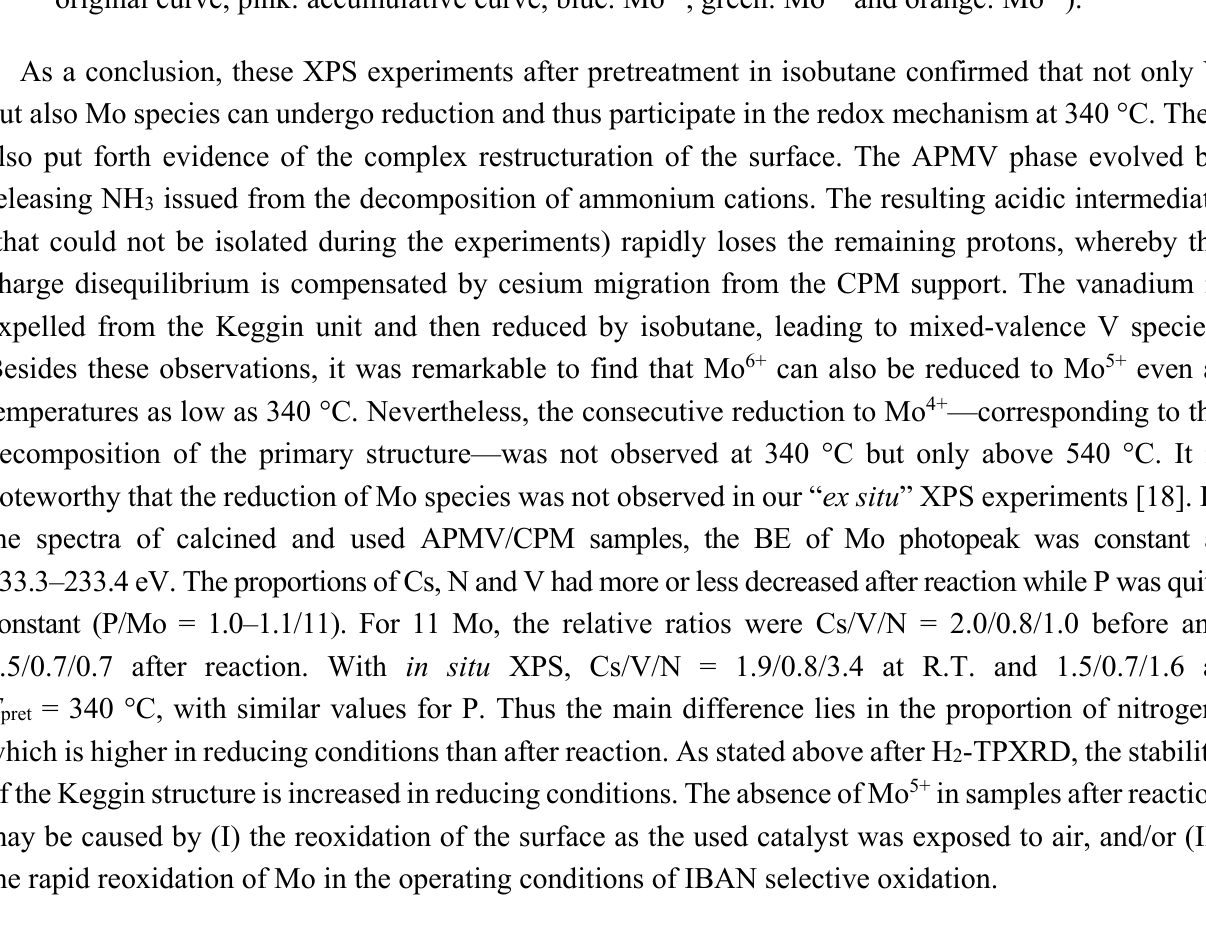
Figure 10. Reduction process of Mo species under isobutane observed by in situ XPS (black: original curve, pink: accumulative curve, blue: Mo 6+ , green: Mo 5+ and orange: Mo 4+